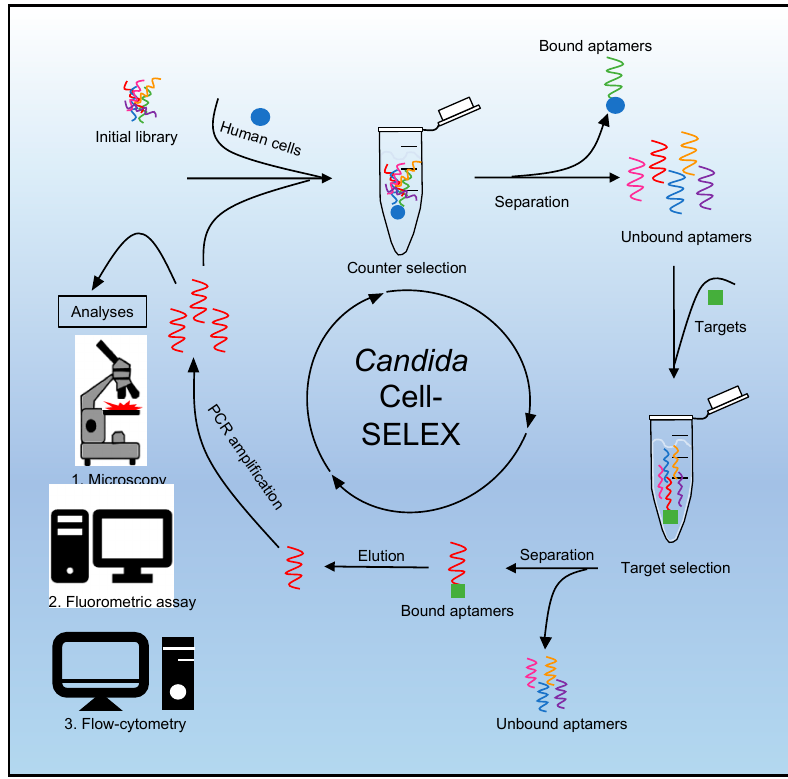
Figure 1. SELEX process and analytical techniques. Starting with a counter selection where an initial single-stranded (commercial) aptamer library (TriLink BioTechnologies, Inc, San Diego, CA, USA) with approximately 6 × 10 14 individual molecules is incubated with human cells as the counter target. Bound aptamers can be removed by a washing step to exclude them from further selection. The focused library is used in a target selection by incubating it with target cells ( Candida ). Aptamers that do not bind to target cells are removed by washing. The aptamers specifically bound to the cells can now be eluted, amplified by polymerase chain reaction (PCR) using Cy5 and phosphate labeled primers and then subjected as single-stranded molecules to different analyses techniques after strand-separation, which is achieved by a strand digestion with lambda exonuclease. This process is repeated to obtain a specific polyclonal aptamer library for Candida after sufficient rounds of target binding and PCR-mediated amplification. Analytical techniques include 1. Fluorescence microscopy, 2. Fluorometric assay and 3. Flow-cytometry.